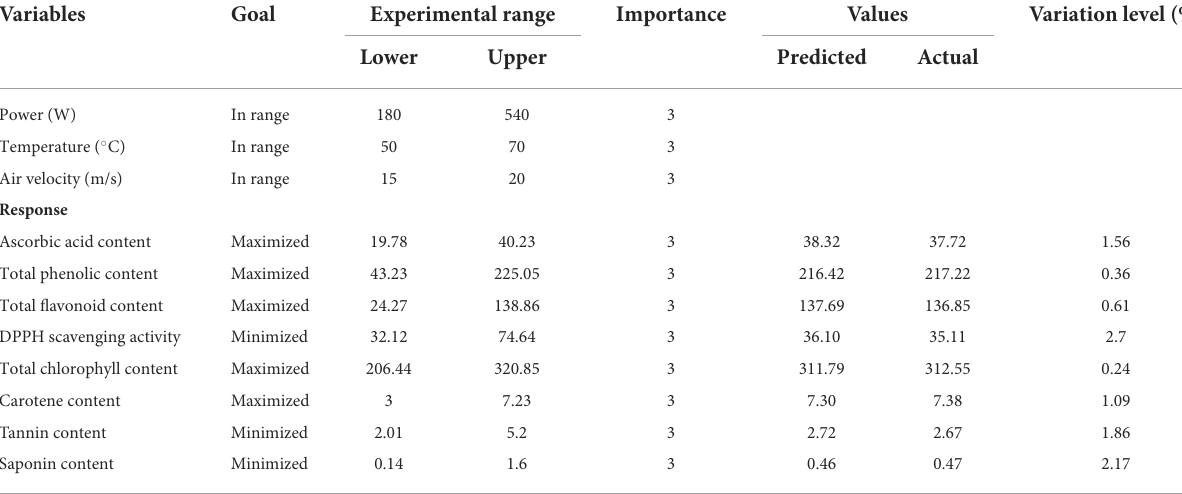
TABLE 4 Simultaneously optimized microwave assisted fluidized bed drying conditions with target and predicted values of investigated